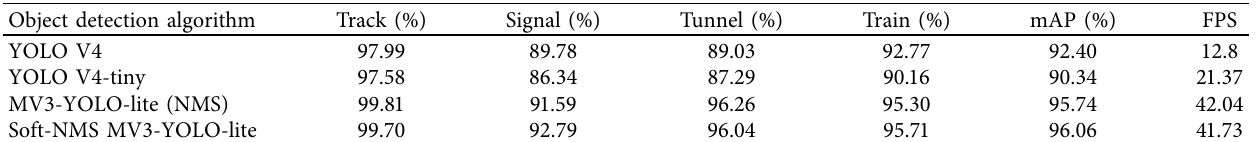
Table 5: Ablation results.